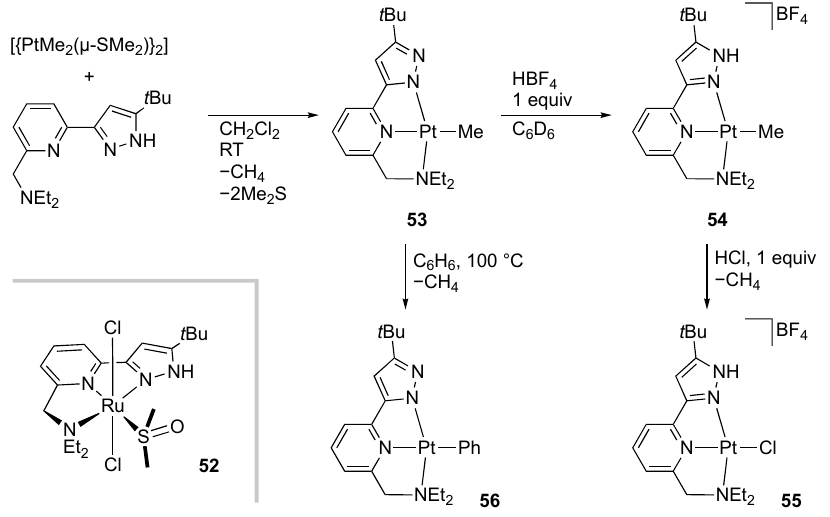
Scheme 16. Synthesis and reactions of NNN pincer-type pyrazole platinum complexes bearing an aminomethyl